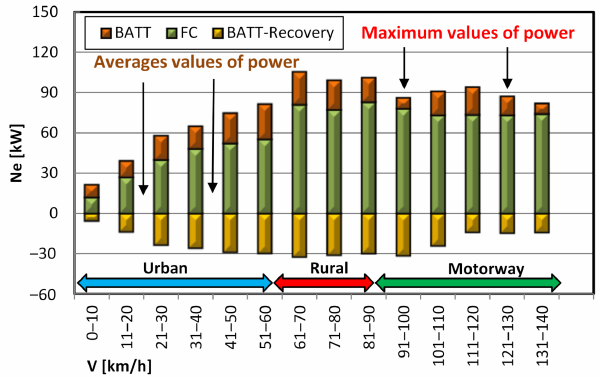
Figure 7. Average and maximum changes in battery (discharge and regeneration) and fuel cell contributions during each phase of the RDC